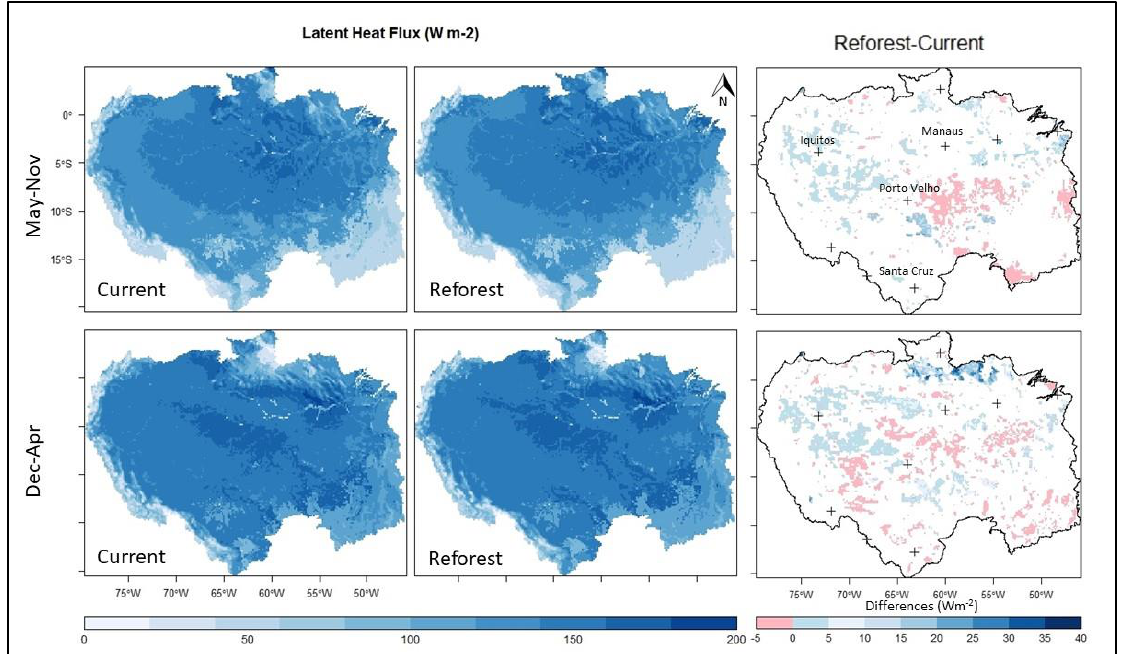
Figure 4. Simulated LH, forced with current and reforested land cover on the left. On the right, the difference between the two simulated LHs at a 95% significance level. Plus signs indicate major cities.